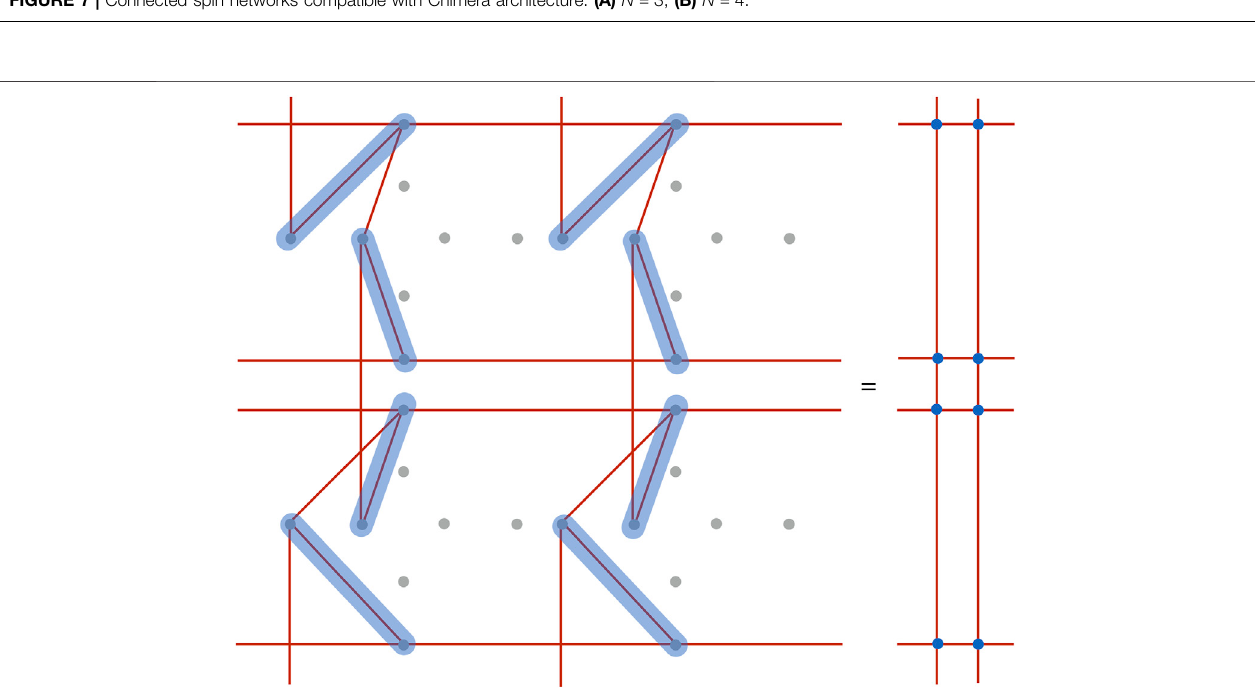
FIGURE 8 | Regular lattice spin network embedded with the use of chain qubits. Here, four 8 qubit blocks of the D-Wave processor are used.